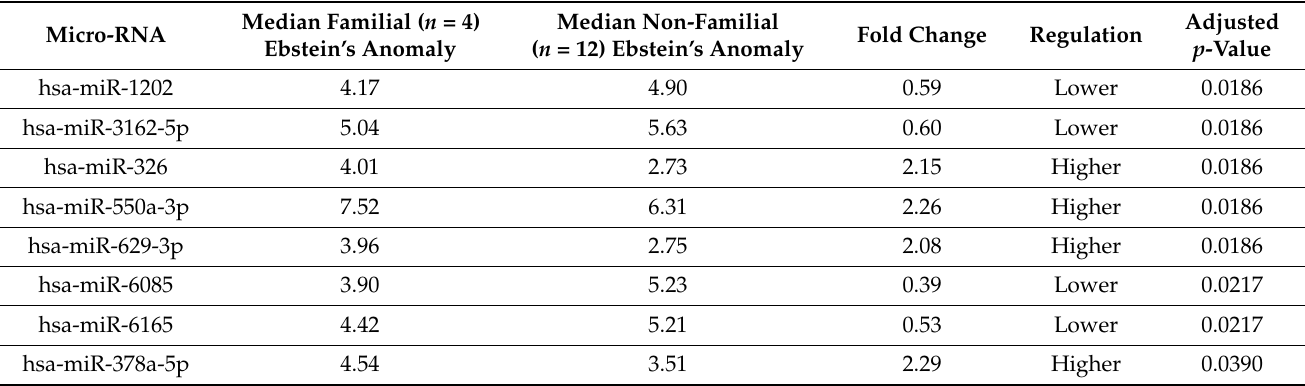
Table 3. Significantly dysregulated miRNA in the blood of patients with familial Ebstein’s anomaly compared to non-familial Ebstein’s anomaly